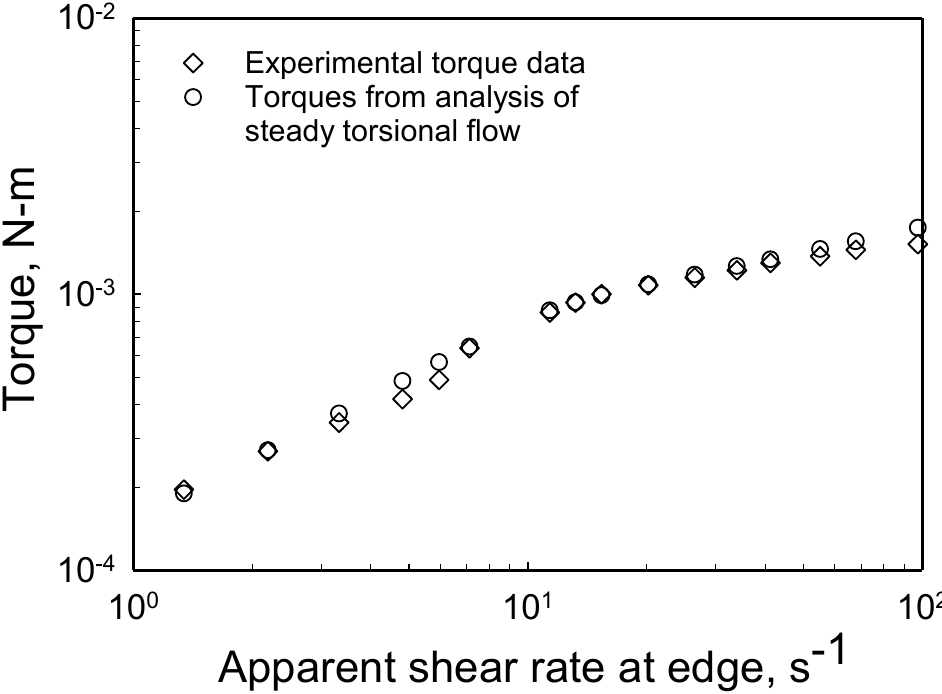
Figure 17. The comparisons of the converged torques obtained via numerical integration employing the characterized parameters of wall slip and shear viscosity with the experimental torque values.